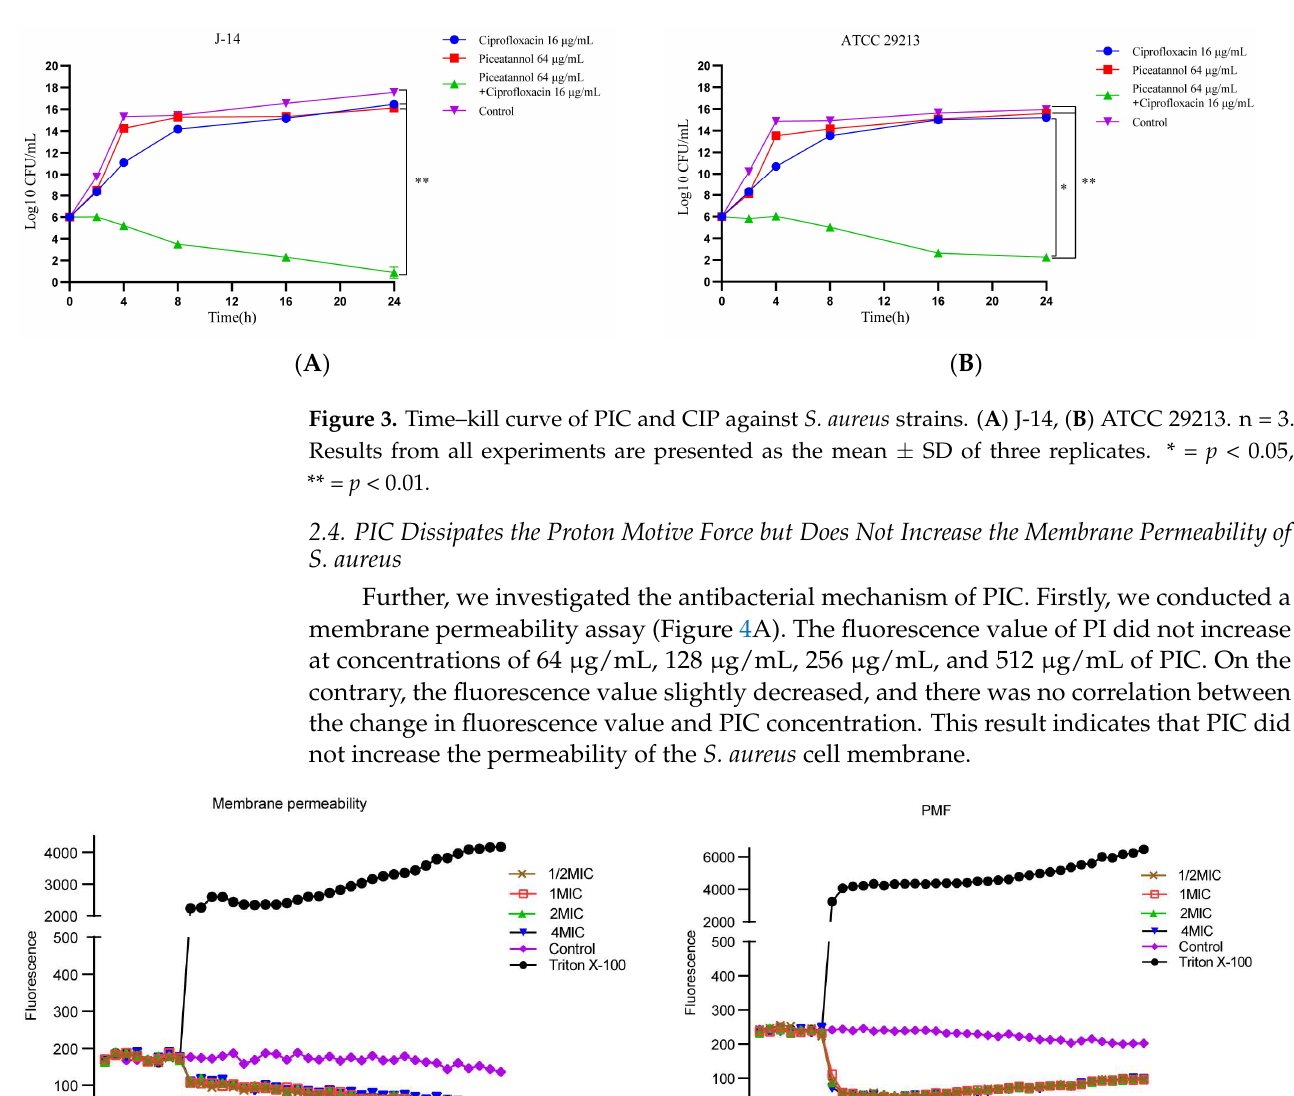
( B ) Figure 5. Effect of pH on the ability of PIC to dissipate S. aureus ATCC 29213 PMF. ( A ) pH of PBS with different concentrations of PIC. ( B ) MBC of PIC against S. aureus ATCC 29213 at different pH. n = 3. Results from all experiments are presented as the mean ± SD of three replicates.